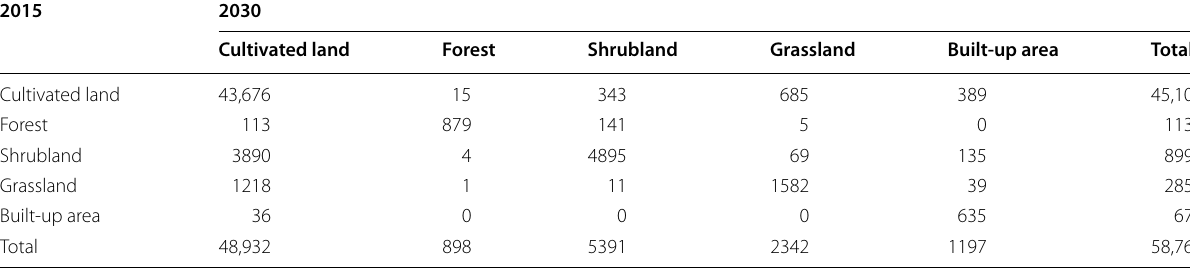
Table 12 Land use/land cover conversion matrix (ha) for the period 2015 and 2030